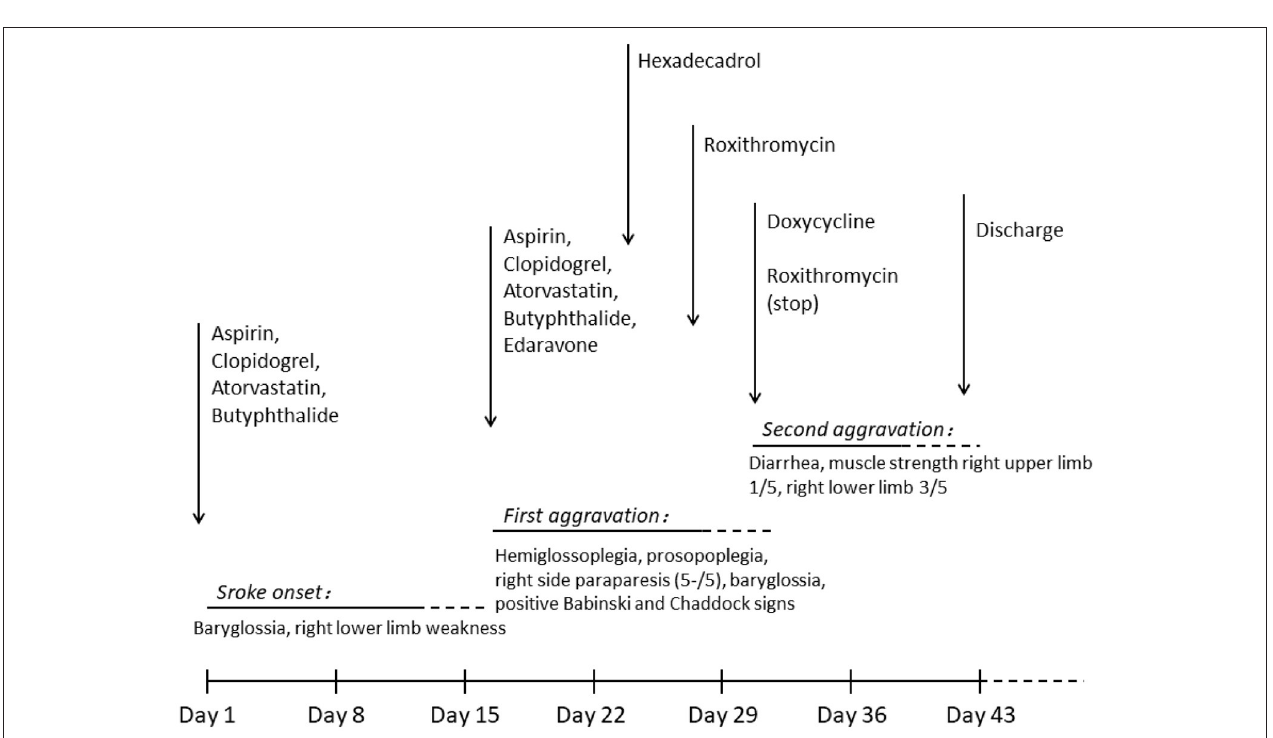
FIGURE 4 | Timeline of stroke aggravation and intervention. Stroke occurred on day 1 and was aggravated twice (days 16 and 30). Hexadecadrol was initiated on day 23, roxithromycin was initiated on day 27, and roxithromycin was replaced with doxycycline on day 30. The patient was discharged on day 41. Assessment score was 17/30. Cognitive impairment, neurological impairment, damage to intracranial arteries, positive CSF TPPA test results, and elevated CSF protein levels and leukocyte counts were identified. Neurosyphilis, as generalized paresis of the insane and meningovascular syphilis, was considered. Antibiotic treatment was initiated. Roxithromycin (500 mg, four times orally per day) was administered as the patient was allergic to penicillin and ceftriaxone. Hexadecadrol was initiated 3 days prior to roxithromycin administration, to prevent the herxheimer